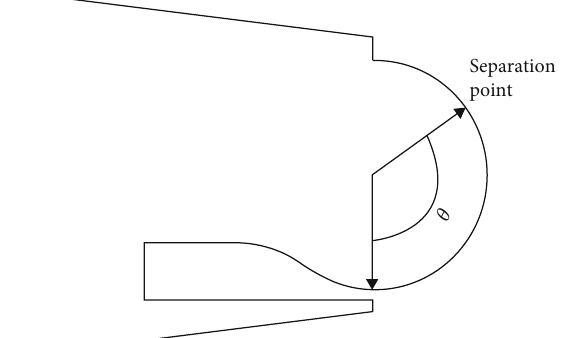
= − 0 : 014 and α = 0 ° at various ride heights. μ